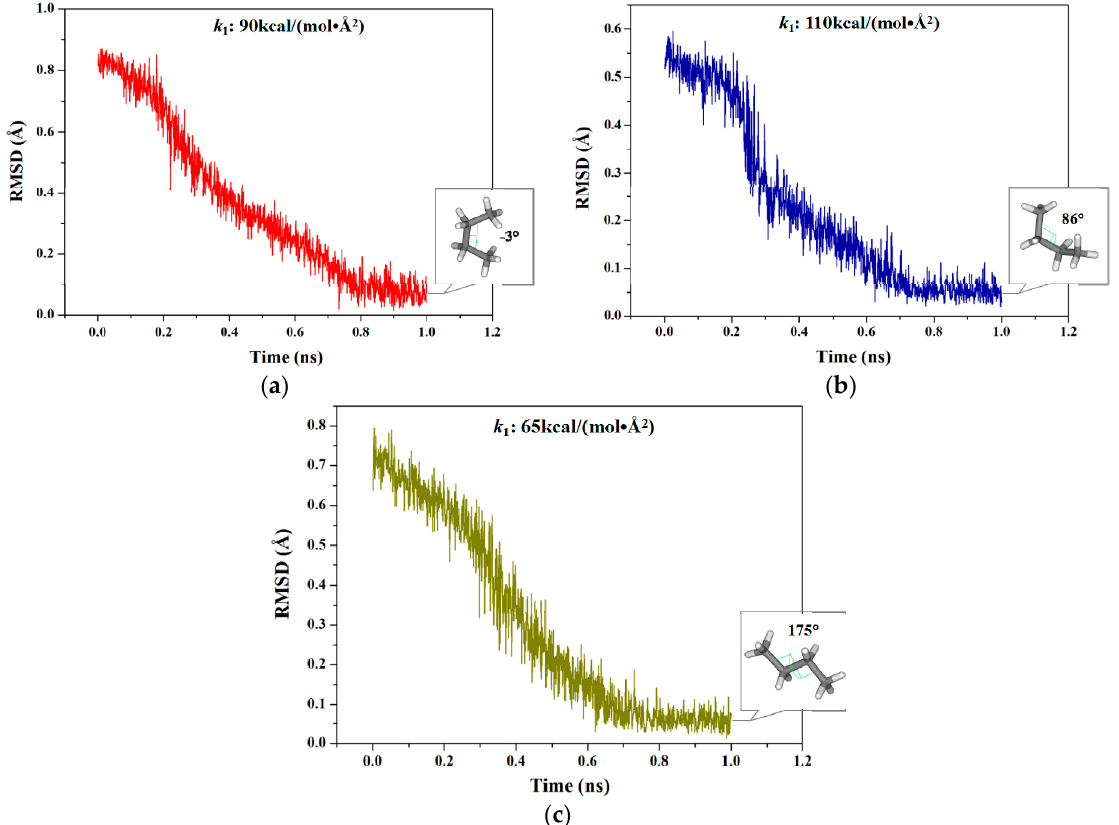
Figure 1. Root mean square deviation (RMSD) values of four C atoms of butane from three individual targeted molecular dynamics (TMD) simulations corresponding to three dihedral angle sections with the respective appropriate force constants: ( a ) 0.84 → 0.00 Å ( − 180° → 0°) in red; ( b ) 0.53 → 0.00 Å ( − 60° → 90°) in blue; and ( c ) 0.73 → 0.00 Å (60° → 180°) in dark yellow. The terminal structure and the corresponding dihedral angle value for each TMD simulation are marked in the square.